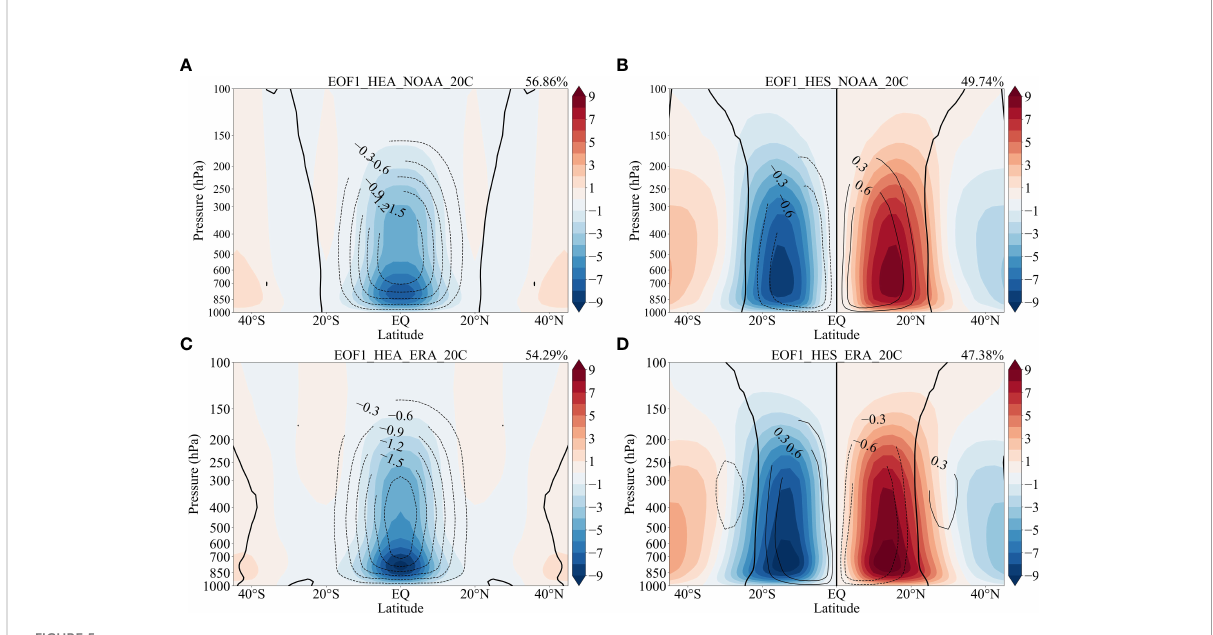
FIGURE 5 As in Figure 4, but for the variation under IPWP cold